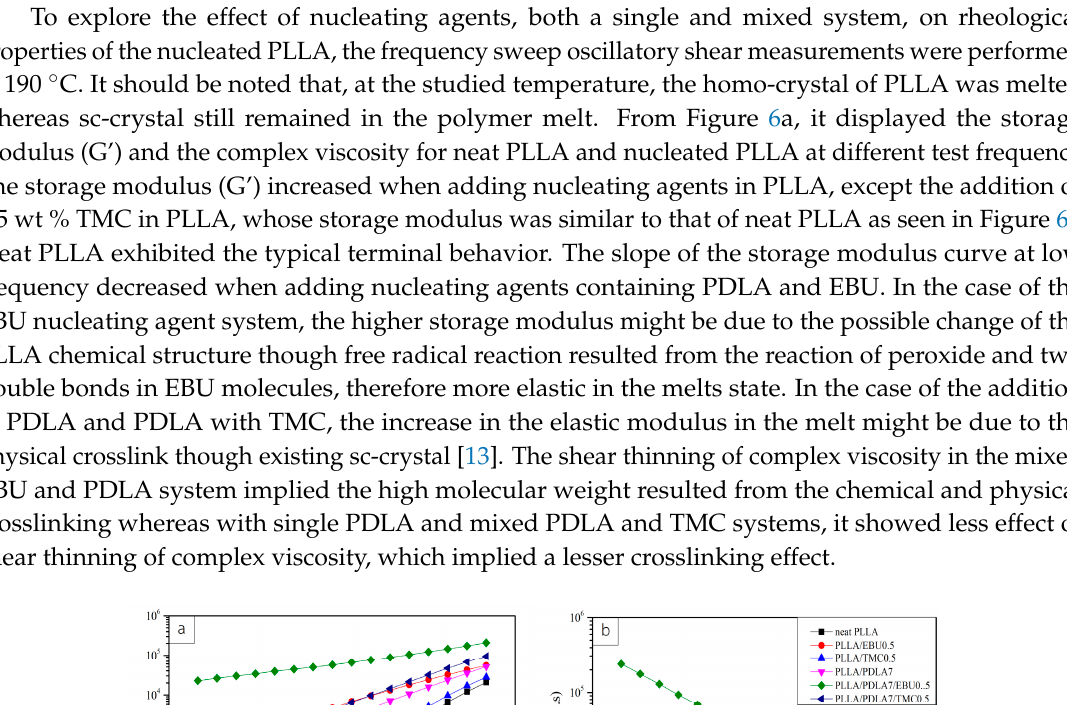
Figure 5. WAXD patterns of nucleated PLLA.